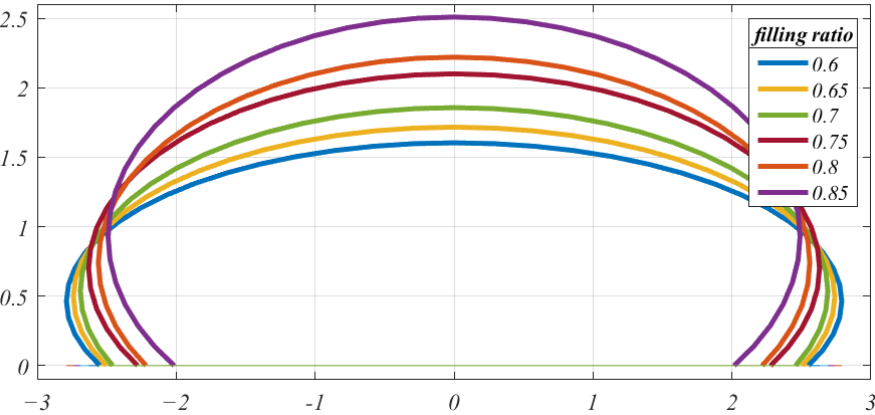
Figure 1. Shapes of partially filled Geotube, in all the practical range of filling; 0.6, 0.65, 0.7, 0.75, 0.8, 0.85. In this example, the filled radius is 2.0 m. The figure is proportional, and the grid spacing is 1.0 m horizontally and 0.5 m vertically.